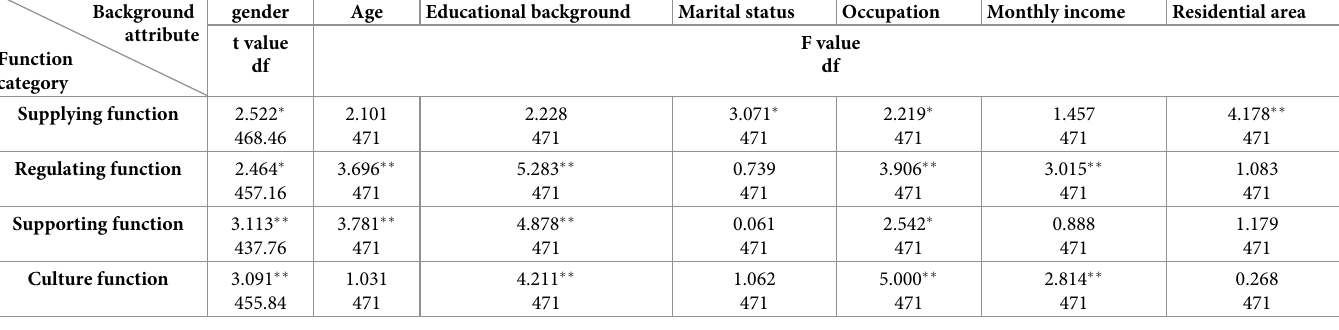
Table 2. The results of analysis of variations in the value placed on ecosystem service functions among tourists to the Guanwu National Forest Recreation Area in Taiwan according to tourist background.